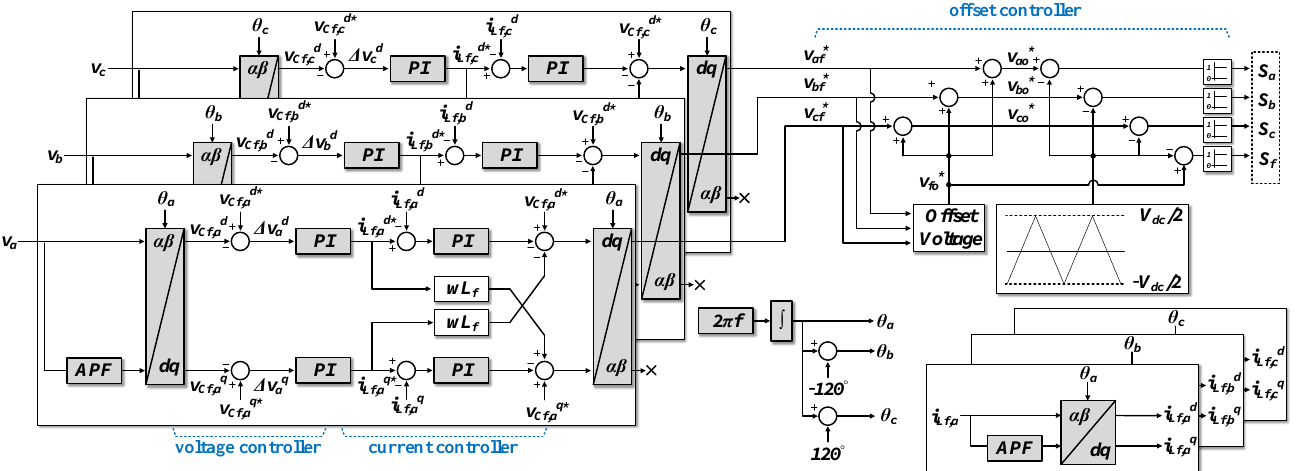
Figure 4. Block diagram of single-phase voltage control algorithm.